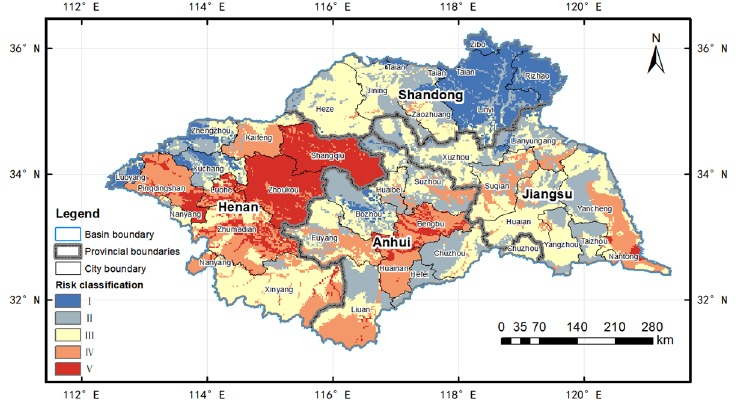
Table 3. Risk level statistics.